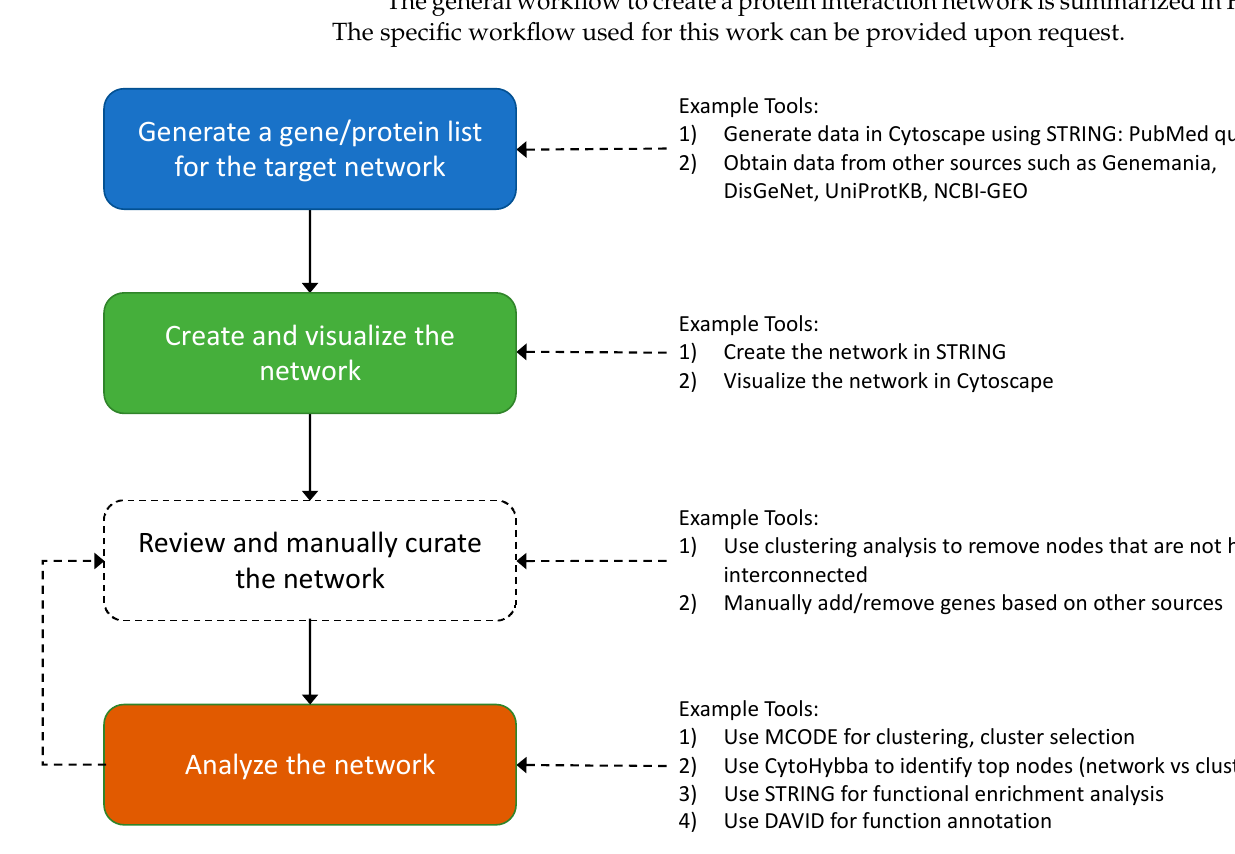
Figure 1. Overview of protein network development and analysis.